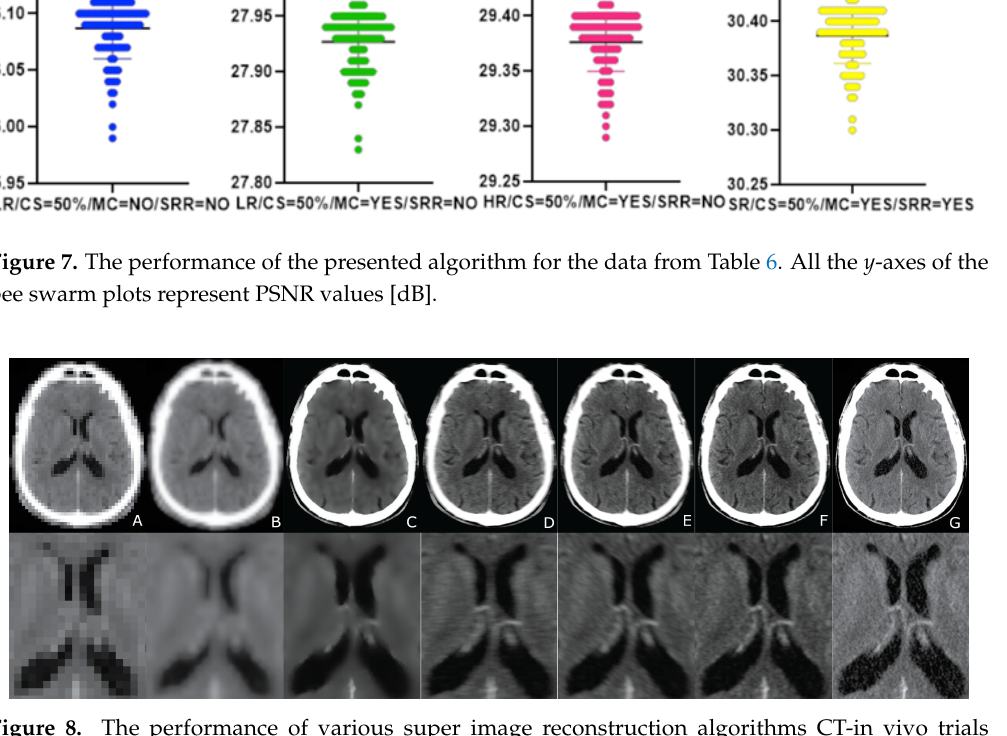
Figure 8. The performance of various super image reconstruction algorithms CT-in vivo trials input images. From left to right: ( A ) LR input; ( B ) B-spline Cubic interpolation; ( C ) Non-Rigid Multi-Modal 3D Medical Image Registration Based on Foveated Modality Independent Neighbourhood Descriptor [25]; ( D ) Enhanced deep residual networks for single Image Super-Resolution [13]; ( E ) Image super-resolution using very deep residual channel attention networks [14]]; ( F ) Residual dense network for Image Super-Resolution [15]; ( G ) the presented algorithm.